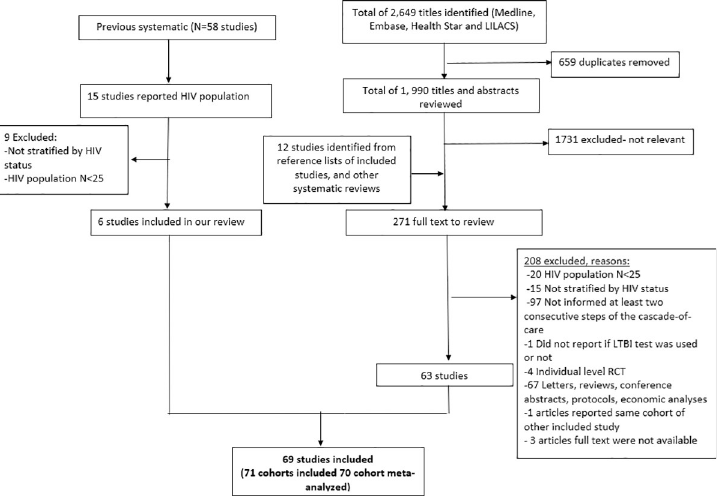
Fig 3. PRISMA flow diagram. LTBI, latent tuberculosis infection; RCT, randomized clinical trial.